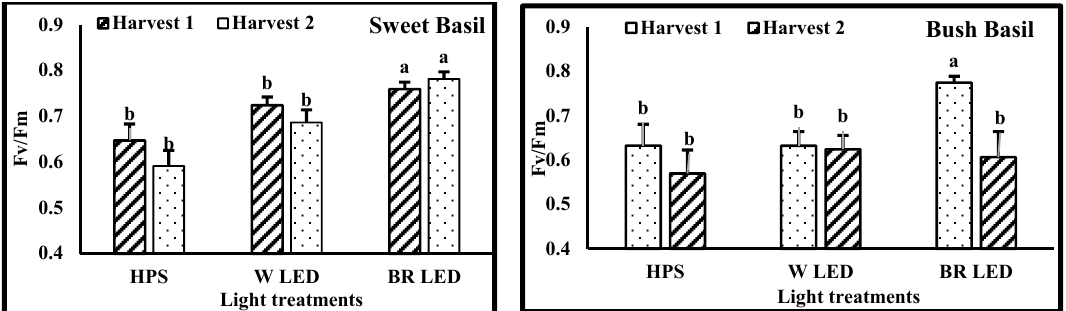
Figure 4. The effect of light treatments and harvest stage on the chlorophyll fluorescence rate Fv/Fm in sweet basil (LSD = 0.042 for the light treatments) and bush basil (LSD = 0.05 for the harvest stage). Different letters denote significant differences between treatments ( p < 0.05).